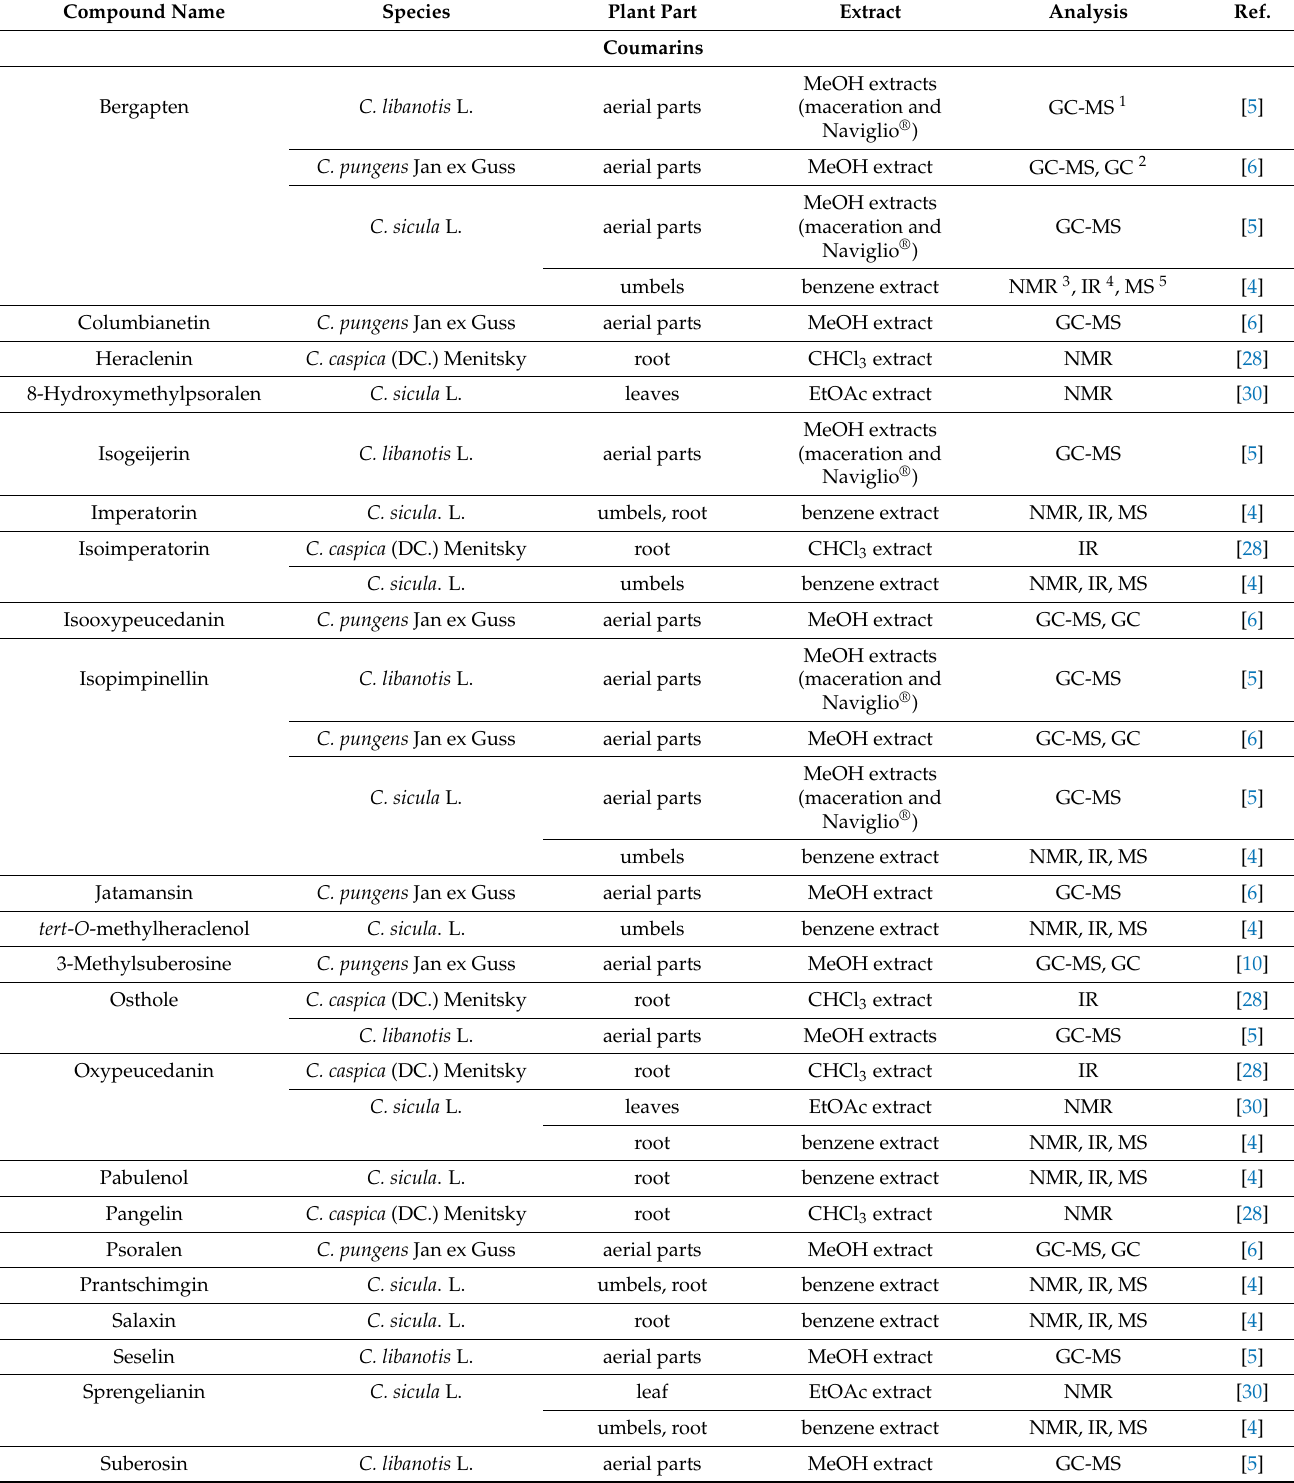
Table 2. Phytochemical constituents identified in Cachrys